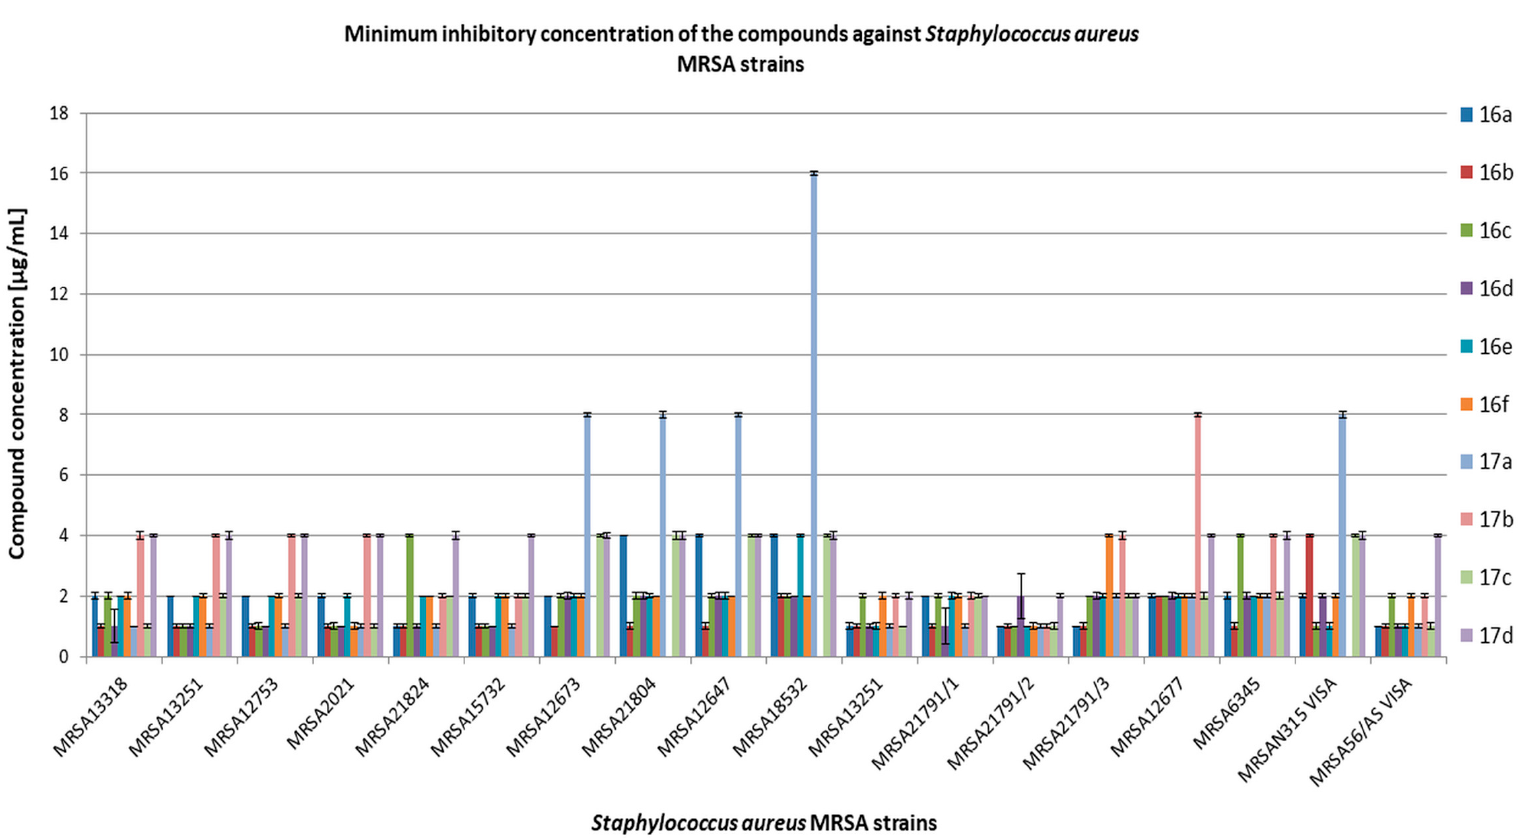
Figure 2. Minimum inhibitory concentration (MIC) [µg/mL] of the compounds on clinical bacterial strains MRSA. VISA—vancomycin-intermediate S. aureus .